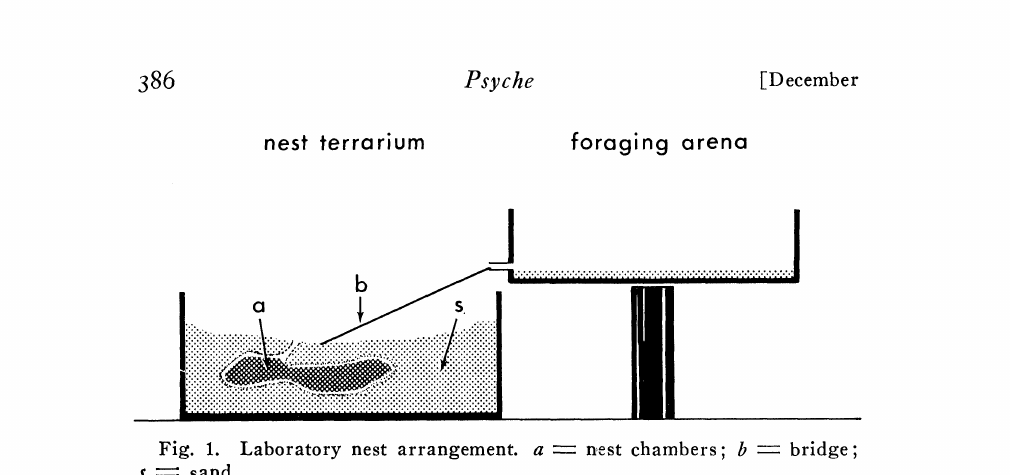
Fig. 1. Laboratory nest arrangement, a "-- nest chambers; b bridge; s